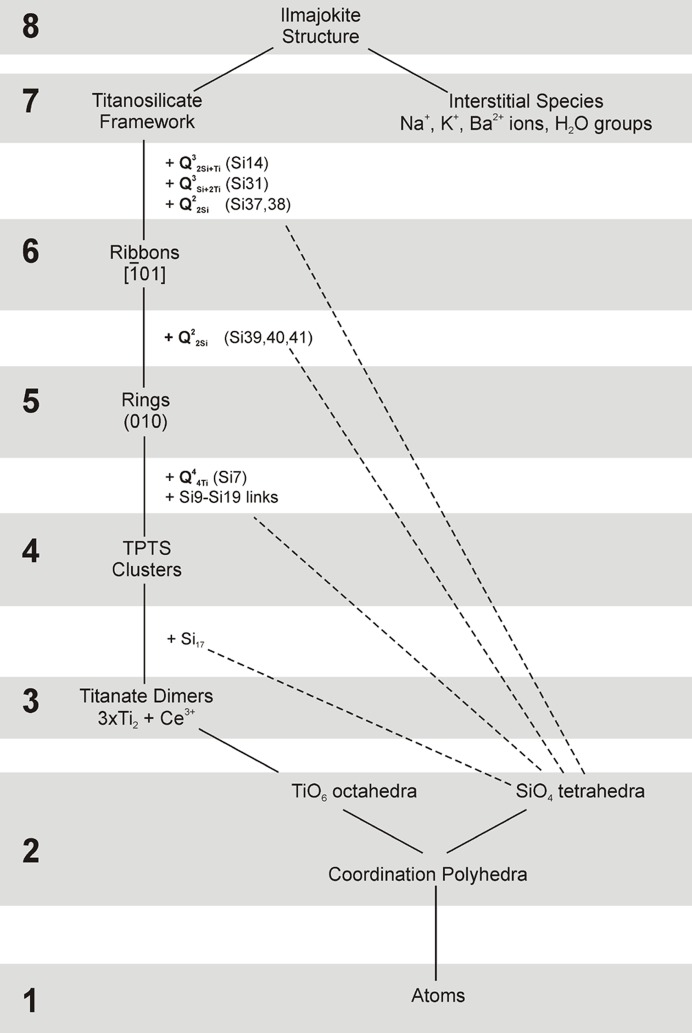
Hierarchial organization of the crystal structure of ilmajokite separated into eight hierarchy levels (highlighted in gray).